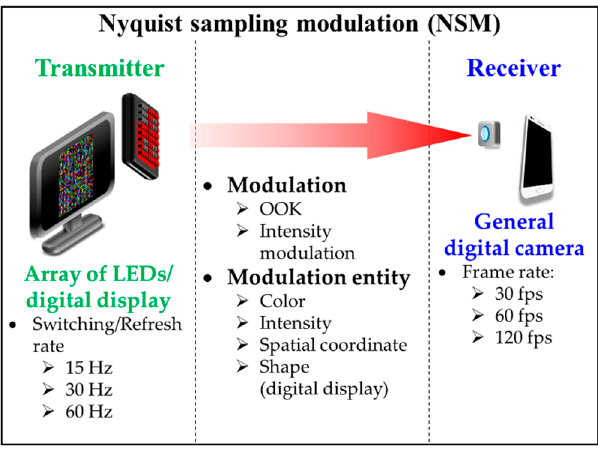
Figure 13. Nyquist sampling modulation.